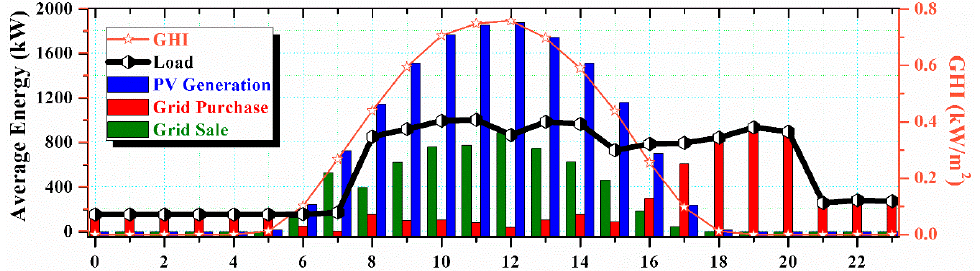
Figure 12. Hourly based yearly average PV energy generation, electrical load, grid sales, grid purchases, and GHI. Energies 2018 , 11 , x FOR PEER REVIEW